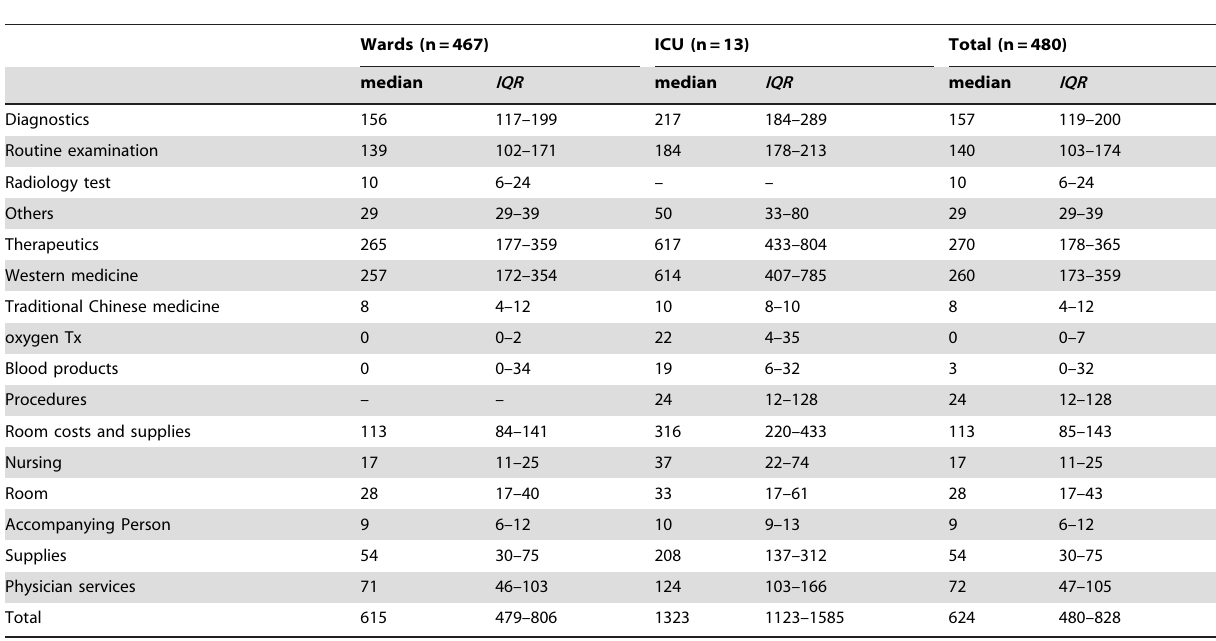
Table 4. Influenza-related hospitalization costs on the wards and in the ICU from Suzhou, China (USD).